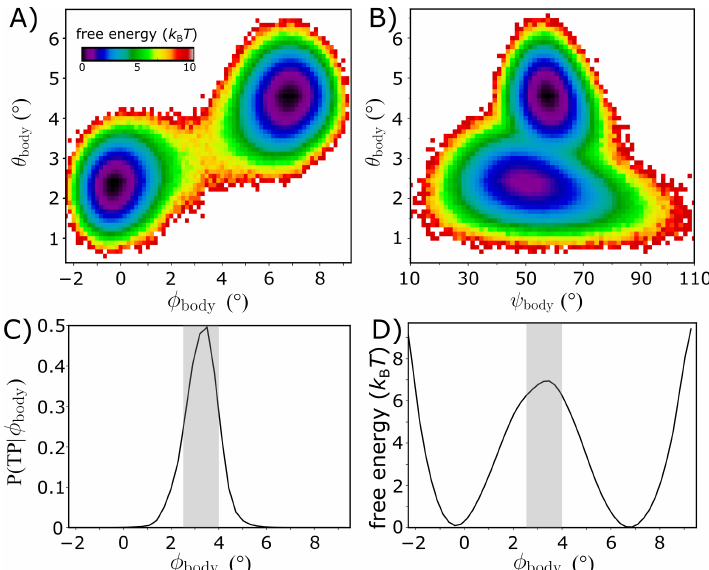
Figure 3. The free-energy landscape of rotation. Equilibrium simulations of the intact yeast ribosome (Figure 2) were used to characterize the energetics of subunit rotation. ( A ) The free energy as a function of φ body and θ body suggests the barrier for rotation is ∼ 7 k B T . Rotation and tilting are correlated, though the simulations reveal that tilting motions are widely accessible within the unrotated ensemble. When φ body ∼ − 1, the tilting angle θ body can adopt values up to ≈ 4 ◦ . Similarly, there is a range of ∼ 4 ◦ in the tilt angle for the rotated ensemble. This indicates that, while rotation and tilting are correlated, the motions are only weakly coupled. ( B ) Free energy as a function of the tilt angle θ body and direction of tilting ψ body . Comparison of cryo-EM structures would suggest a single direction of tilting, though the simulations indicate that as the ribosome adopts more tilted orientations, the direction of tilting shifts to slightly higher values of ψ body . As a result, it is appropriate to describe tilting in terms of a twist-like rearrangement that is concomitant with rotation. ( C ) While rotation/tilting involves a complex combination of motions, the kinetics of rotation is described well by the single coordinate φ body . Specifically, the probability of being on a transition path as a function of φ body , P ( TP| φ body ), adopts a peak value of ∼ 0.5. Gray area indicates the identified TSE region. ( D ) The free energy as a function of φ body also yields a barrier that is comparable to that of the two-dimensional landscape shown in panel